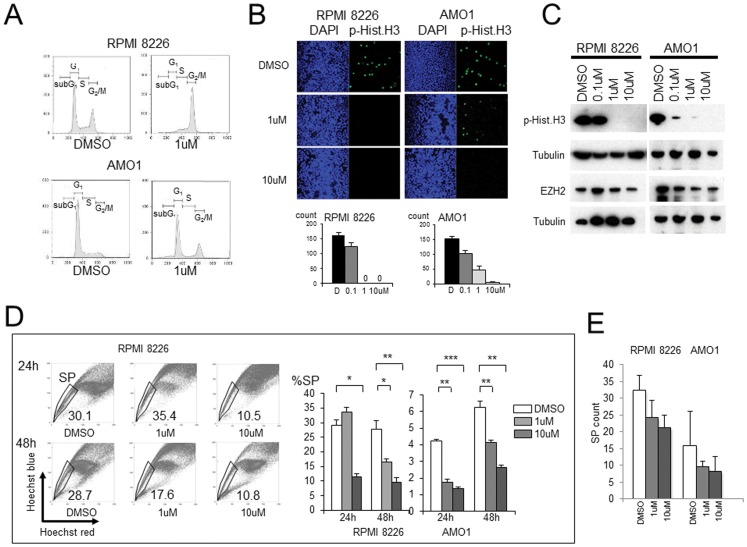
Effect of Aurora kinase inhibitor (VX-680) on myeloma SP cells.(A). Cell cycle analysis of RPMI 8226 and AMO1 cells exposed toVX-680 (1 µM). X-axis, PI; Y-axis, cell count. RPMI 8226+DMSO: subG1 1.1%, G0/G1 47.3%, S 18.5%, G2/M 33.2%; RPMI 8226+VX-680 (1 uM): subG1 1.7%, G0/G1 3.4%, S 16.4%, G2/M 78.5%. AMO1+DMSO: subG1 1.9%, G0/G1 82.5%, S 22.4%, G2/M 12.9%; AMO1+VX-680 (1 uM): subG1 8.4%, G0/G1 54.8%, S 10.5%, G2/M 30.7%. (B). Detection of M phase cells among VX-680-treated MM cells. Upper panels: DAPI and p-Hist.H3 staining (green) of cells treated with DMSO, 1 µM, and 10 µM VX-680 (24 hr exposure). Under panels: bar graphs showing the numbers of M phase cells after treatment with the indicated concentration of VX-680 (24 hr exposure). (C). Western blot analysis of p-Hist.H3, EZH2 in RPMI 8226 (left panel) and AMO1 (right panel) cells; Tubulin is the control. (D). Flow cytometric analysis of RPMI 8226 SP cells. Dot plots of cells stained with Hoechst 33342 alone, Hoechst 33342 in the presence of 1 µM VX-680 or Hoechst 33342 in the presence of 10 µM VX-680. Left upper panels: 24 h exposure to VX-680; left lower panels: 48 h exposure to VX-680. Bar graphs of SP cell fractions (%) of indicated cells treated with VX-680 (DMSO, 1 µM, 10 µM) for 24 hr or 48 hr are also shown besides the flow cytometric analysis. DMSO is the control. Asterisks (*) indicate statistical significance: *0.01≤P<0.05, **0.001≤P<0.01, ***P<0.001. Bars are means ± SD of triplicate samples. (E). CFC assay. Colonies of SP by VX-680 (DMSO, 1 µM, 10 µM) for RPMI 8226 and AMO1 cell lines. Colony count was examined after 10 days from SP or MP distribution.